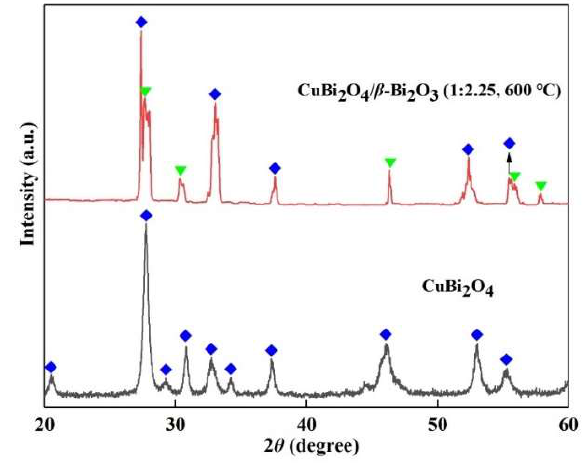
Figure 3. X-ray diffraction (XRD) patterns of CuBi 2 O 4 and CuBi 2 O 4 / β -Bi 2 O 3 (1:2.25, 600 °C).